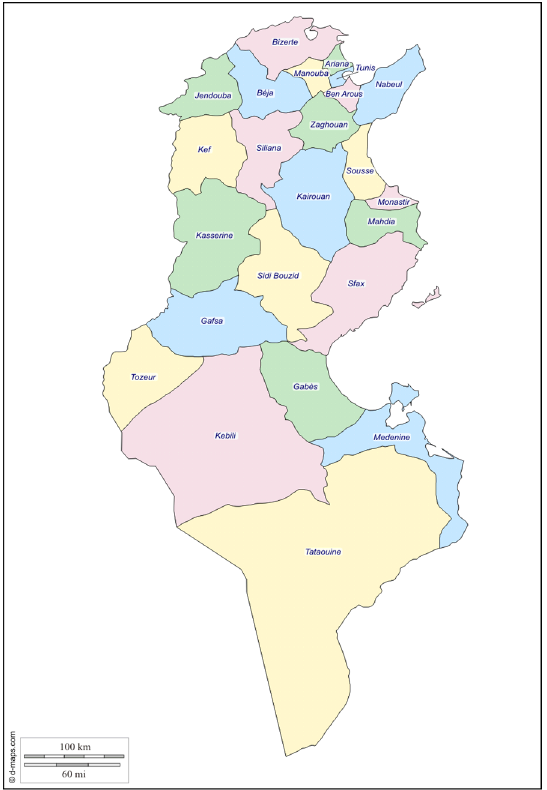
Figure 2. Map of Tunisia indicating the regions where milk thistle seed samples were gathered (from the north to the south: Bizerte, Zaghouan,